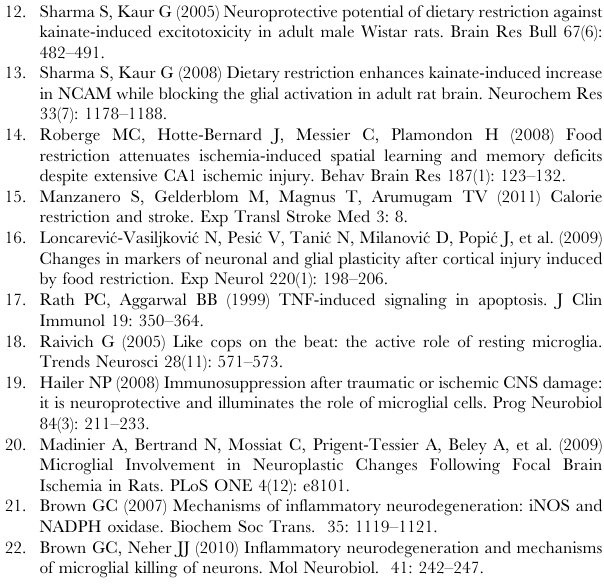
Figure S1 Morphology of microglial cells of AL and CR control animals. Iba-1 staining of the ipsilateral cortex of AL and CR control animals. Microglial cells of AL and CR groups display the same ramified morphology. Representative sections at 20 6 and 40 6 magnification (n= 3 animals per experimental group). (TIF) Figure S2 Morphology of microglial cells in the contra- lateral hemisphere of AL and CR animals. Representative sections showing Iba-1-staining of the homotypical cortex to the injured area in the contralateral hemisphere, in both AL and CR animals on the 2nd day following injury. Microglial cells of AL and CR groups display the same, ramified morphology. Representative sections at 20 6 magnification (n= 3 animals per experimental group). (TIF) Figure S3 Fluoro-Jade B/Hoechst staining of the con- tralateral hemisphere of AL and CR animals. Represen- tative sections showing Fluoro-Jade B/Hoechst staining of the homotypical cortex to the injured area in the contralateral hemisphere, in both AL and CR animals on the 2nd day following injury. Degenerating neurons were not observed in brain sections of AL nor CR animals. Images are representative of brain sections at the site of the lesion (n= 3 animals per experimental group). Blood vessels (arrowheads); magnification 20 6